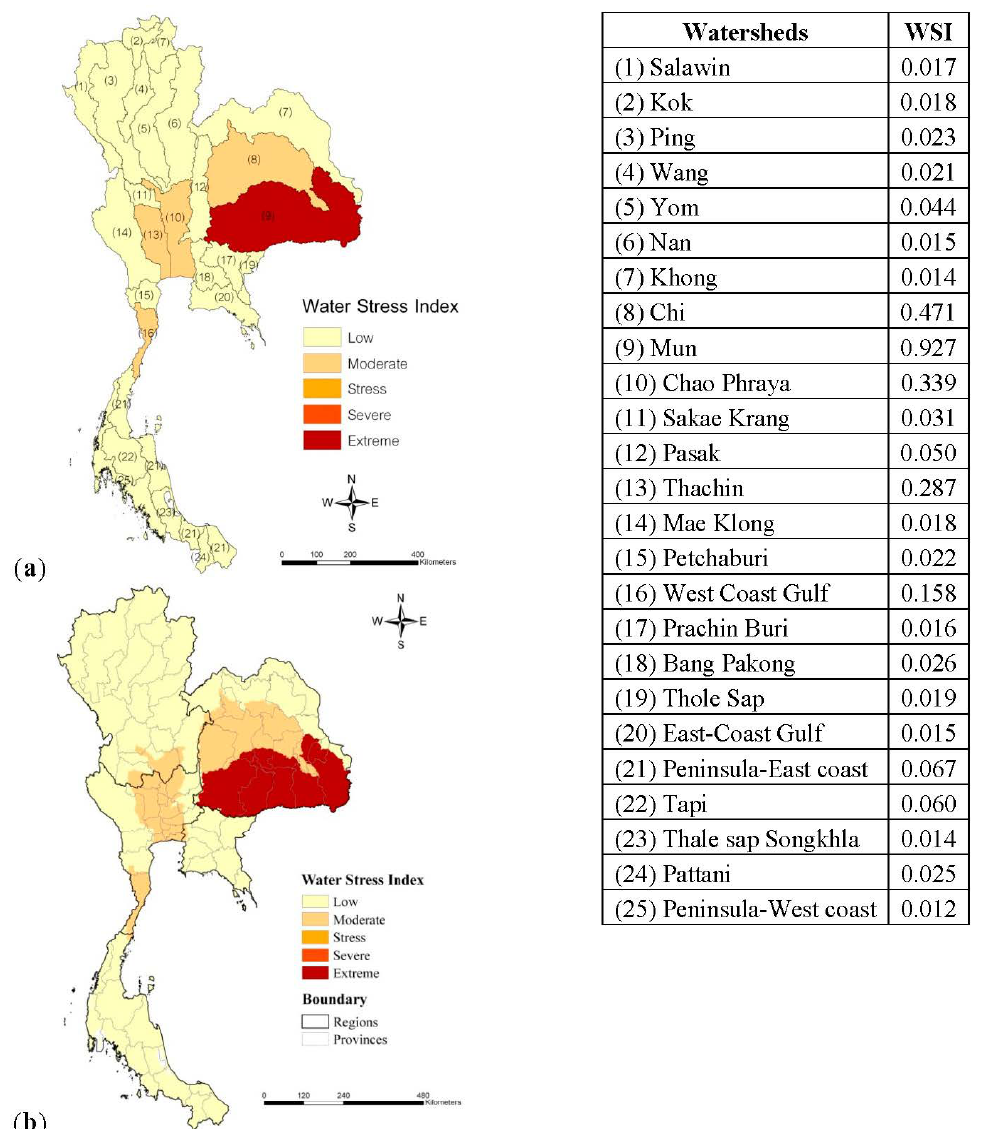
Figure 4. Water stress index based on average annual rainfall classified by ( a ) watersheds; and ( b )